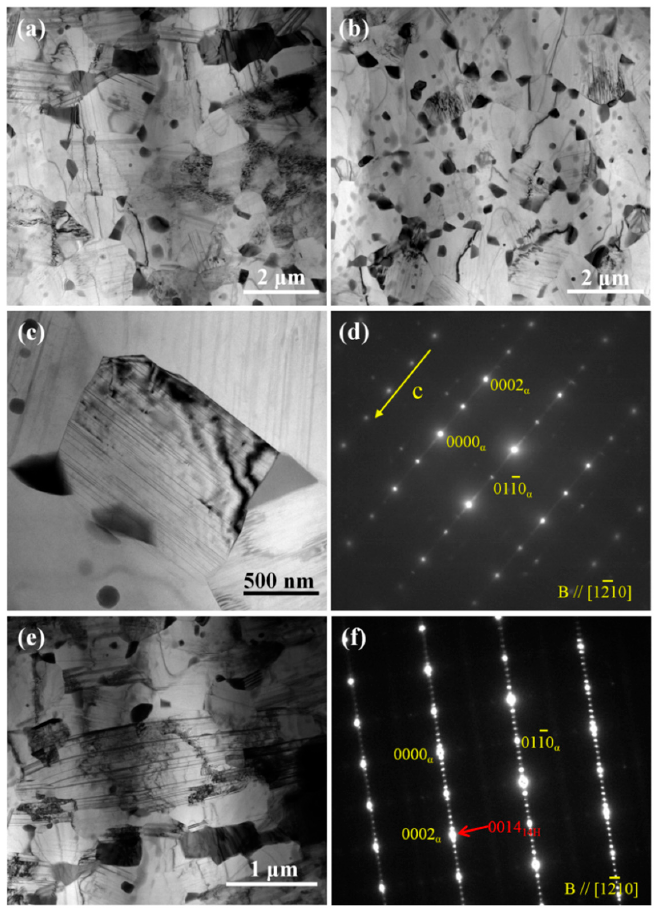
Figure 6. TEM analyses of the as-extruded alloy: ( a – c , e ) bright-filed TEM images; ( d ) SEAD pattern of lamellar structure within grain; ( f ) SEAD pattern of the block in matrix. Notes that yellow and red arrows represent superstructured la tt ice.